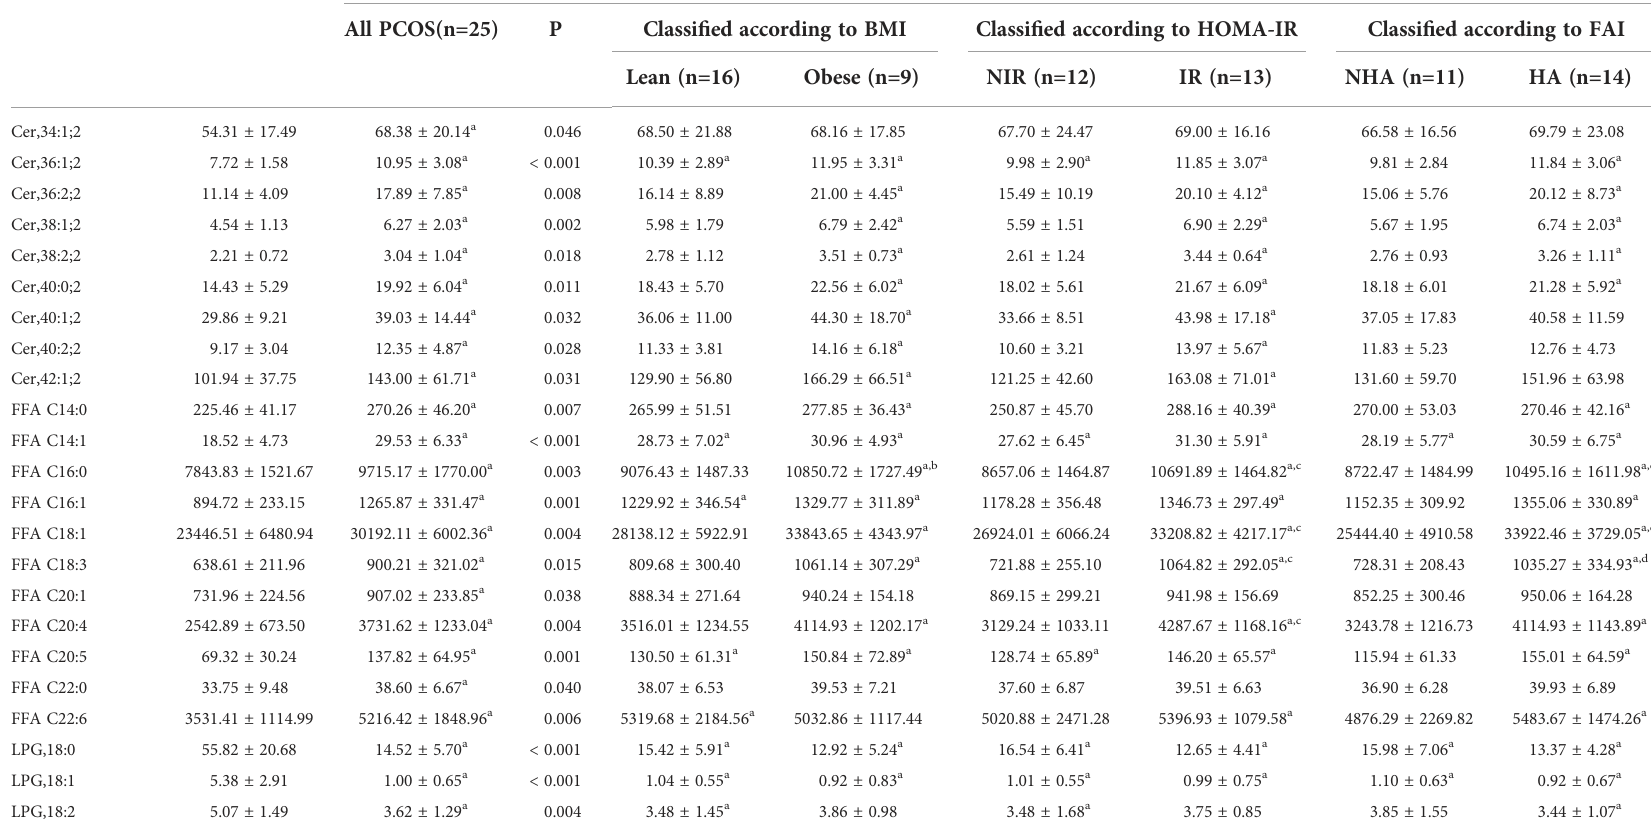
TABLE 3 FF lipid subclasses in controls and women with